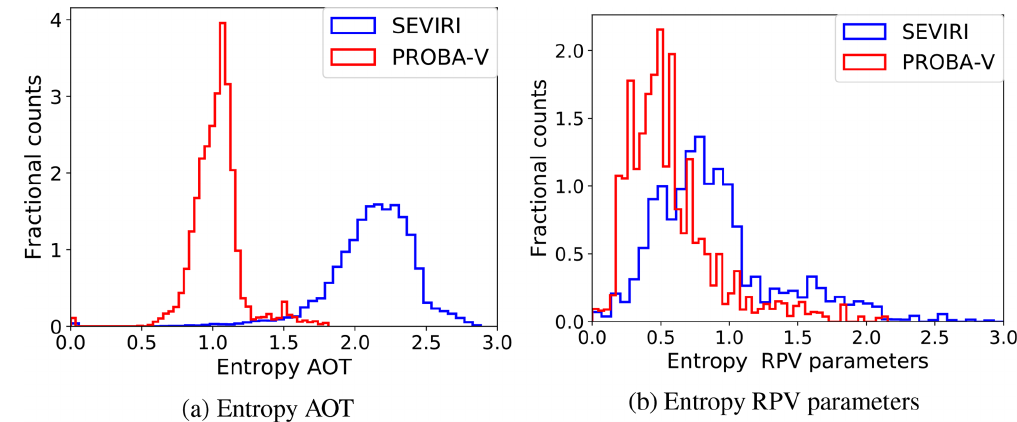
Figure 9. Distribution of the entropy related to the AOT ( a ) and to the RPV parameters ( b